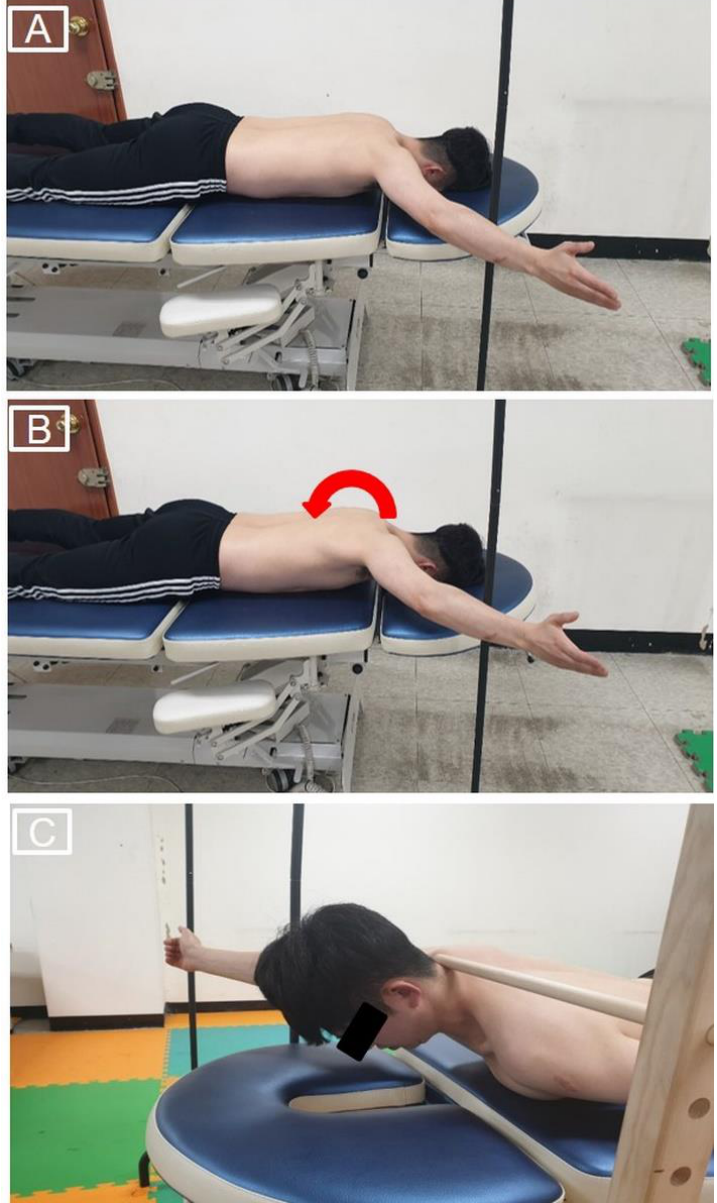
Figure 4. Preferred prone shoulder horizontal abduction ( A ), prone shoulder horizontal abduction with the intended scapular posterior tilt ( B ), and prone shoulder horizontal abduction with the intended scapular posterior tilt and trunk extension ( C ).